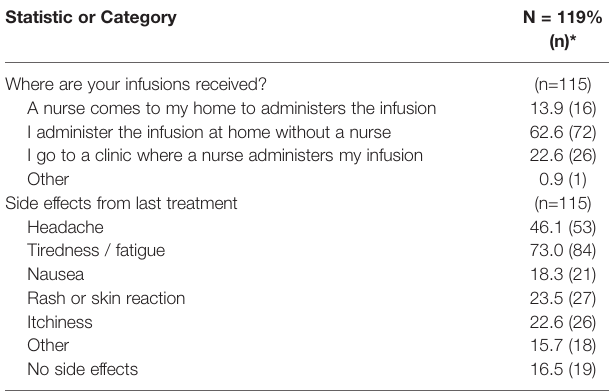
TABLE 2 | Demographic characteristics and respondent disease